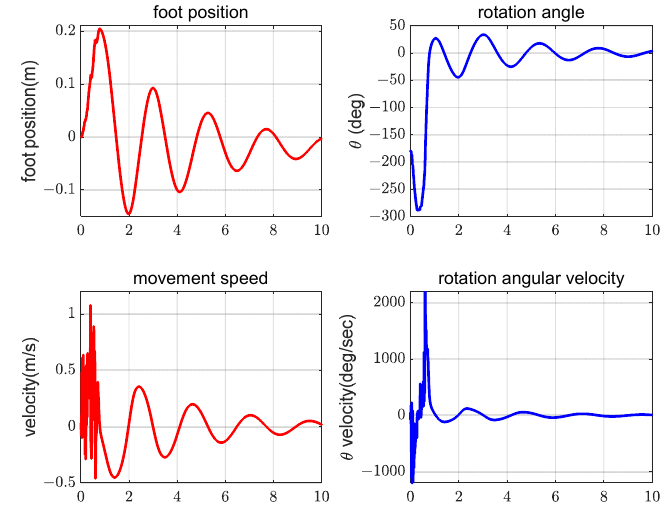
Figure 10. PID control with interference.